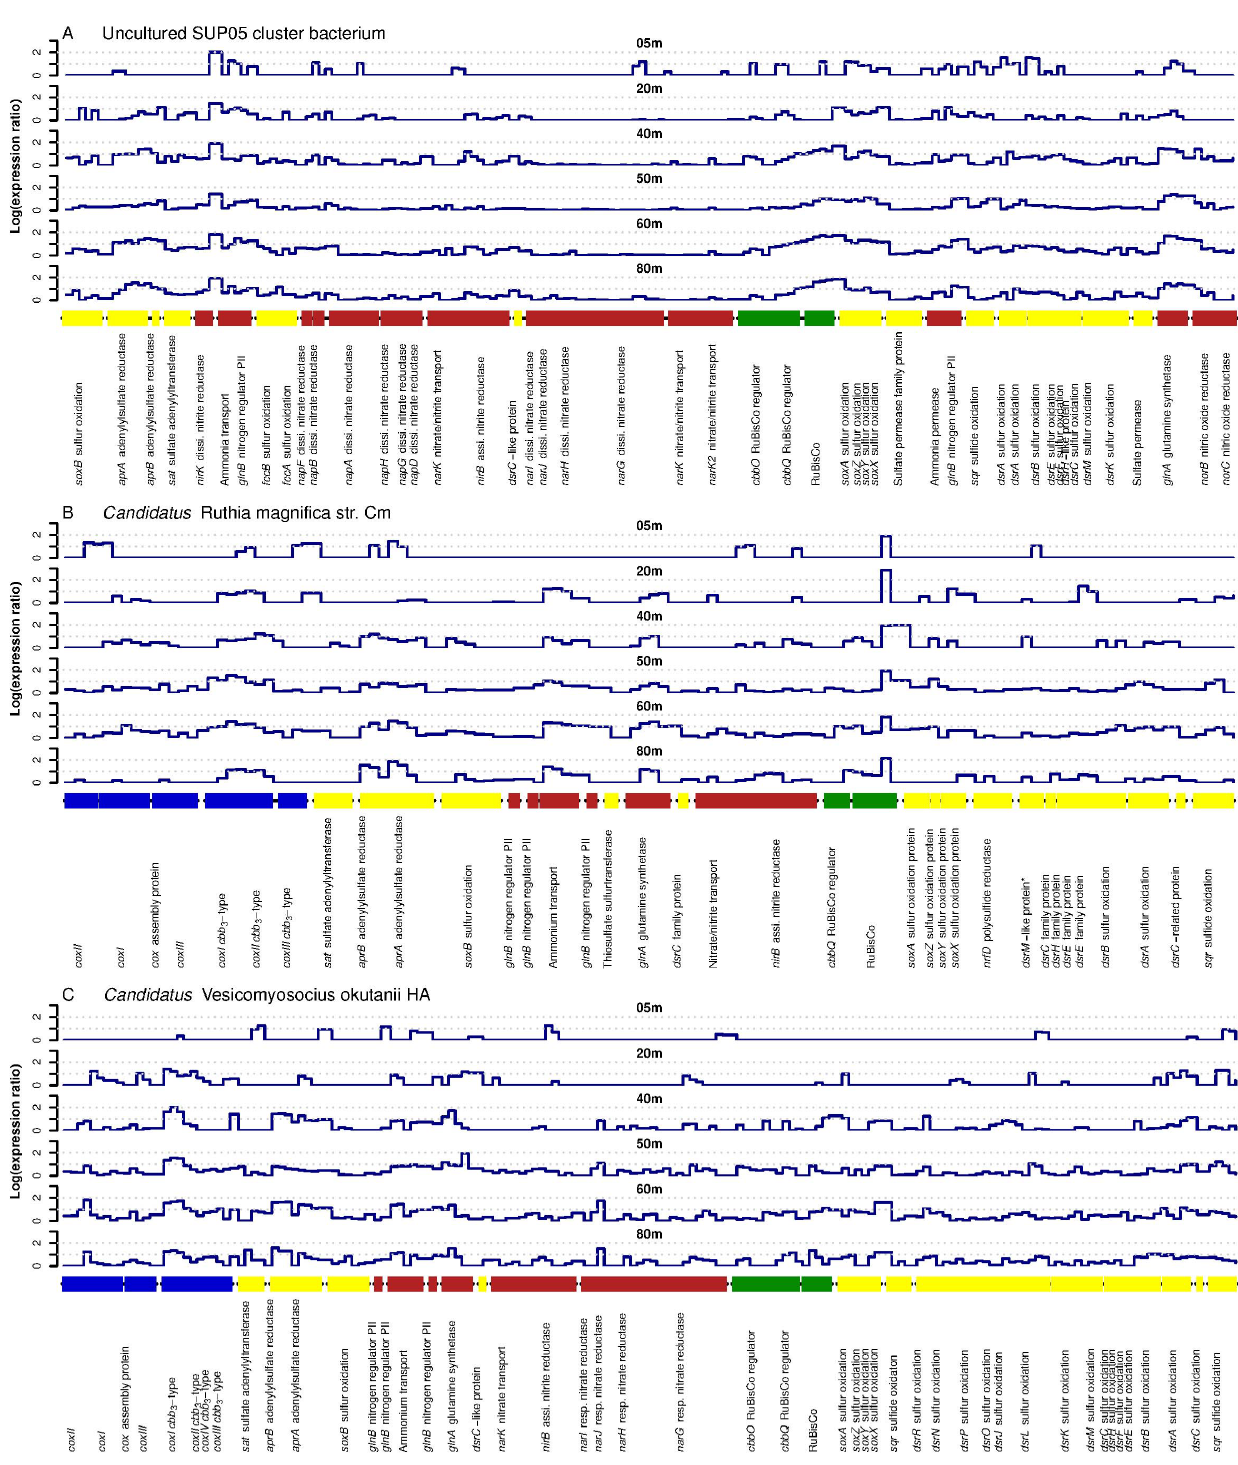
Figure 5. Vertical distribution of sequences recruited onto the genomes of three c -proteobacterial sulfur oxidizers. Shown are selected genes encoding for enzymes involved in oxygen (blue), sulfur (yellow), nitrogen (red) and carbon metabolism (green) in the corresponding order of the genomes. The y-axis depicts the log of the expression-ratio, a measure for the selective enrichment of transcripts over the corresponding gene, normalized to the total pool of protein-coding sequences. A list of the start and end position of all genes and the full names of the corresponding enzymes are shown in Table S3. (A) Uncultured SUP05 cluster bacterium. (B) Candidatus Ruthia magnifica str. Cm. (C) Candidatus Vesicomyosocius okutanii HA. * This DsrM-like protein has also high similarity to a narG respiratory nitrate reductase.